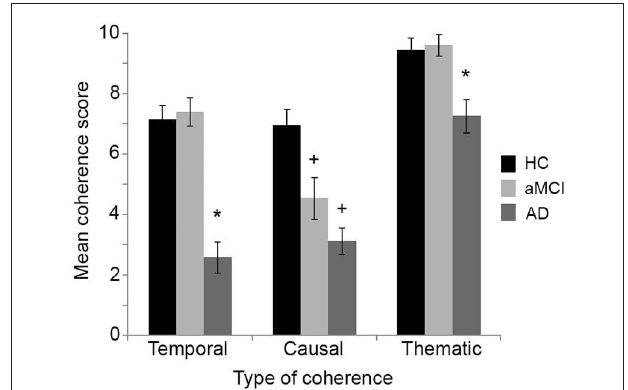
FIGURE 5 | Mean score for each type of coherence (temporal, causal, and thematic) across the whole life story, for each group. HC, Healthy control; aMCI, amnestic Mild Cognitive Impairment; AD, Alzheimer’s disease. Errors bars denote one standard error around the mean. *AD significantly lower than HC/aMCI groups; + Significantly lower than HC